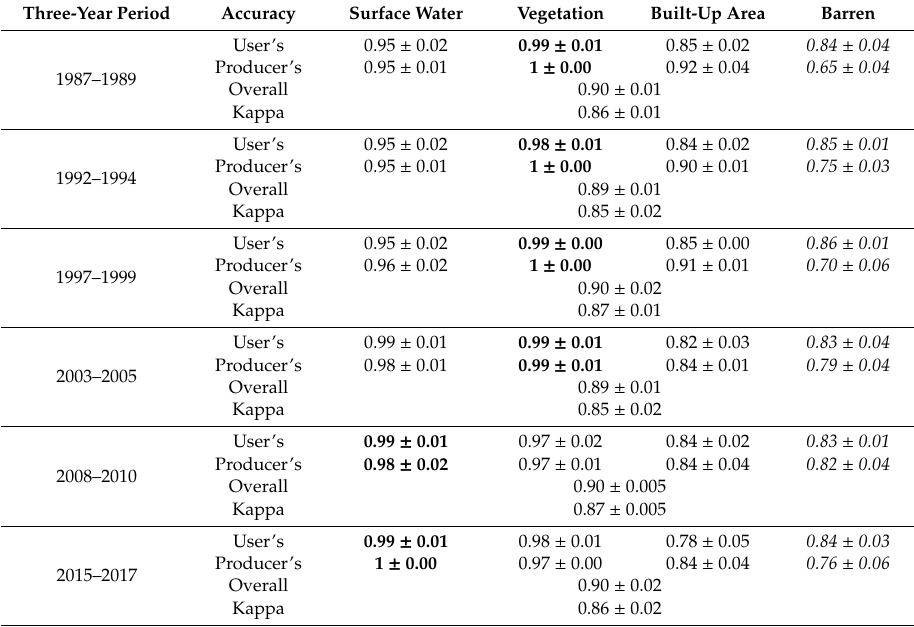
Table 2. Accuracy assessment of the land-cover classification results in the periods 1987–1989,